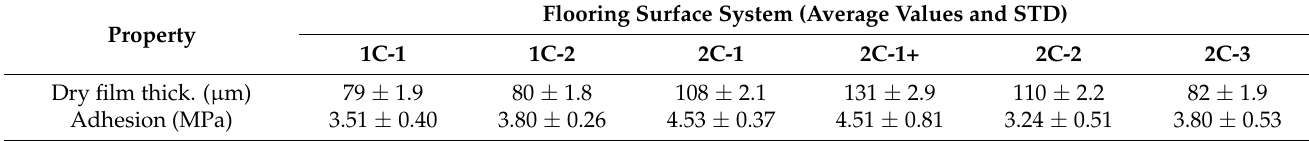
Table 4. Dry film thickness and coating